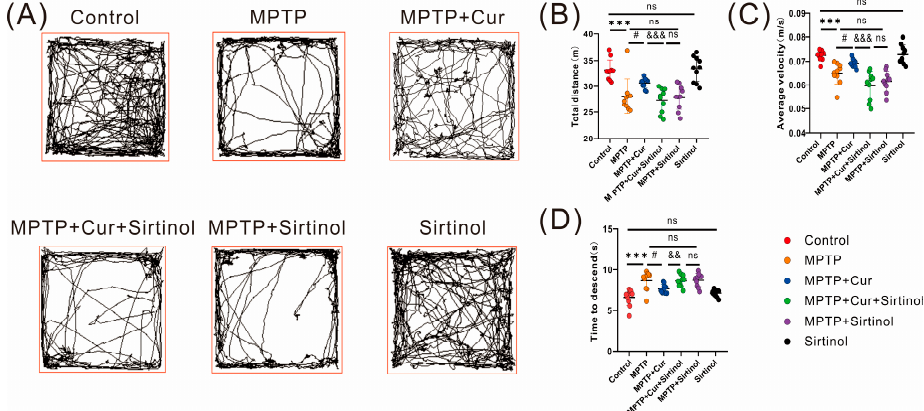
Figure 9. The neuroprotective effect of curcumin was dependent on the gut–brain axis. ( A – C ) Rep- resentative traces and quantification of the open field test among the control, MPTP, MPTP + Cur, MPTP + Cur + Sirtinol, MPTP + Sirtinol, and sirtinol groups ( n = 10); ( D ) quantification of the perfor- mance in the pole test among the six groups ( n = 10); All statistical differences were tested using the t -test ( B – D ). Data are expressed as the mean ± SEM ( n = 10/group). Representative results are for one of the independent experiments. *** p < 0.001 vs. control group. # p < 0.05 vs. MPTP group. && p < 0.01 and &&& p < 0.001 vs. MPTP + Cur group. ns, not significant.